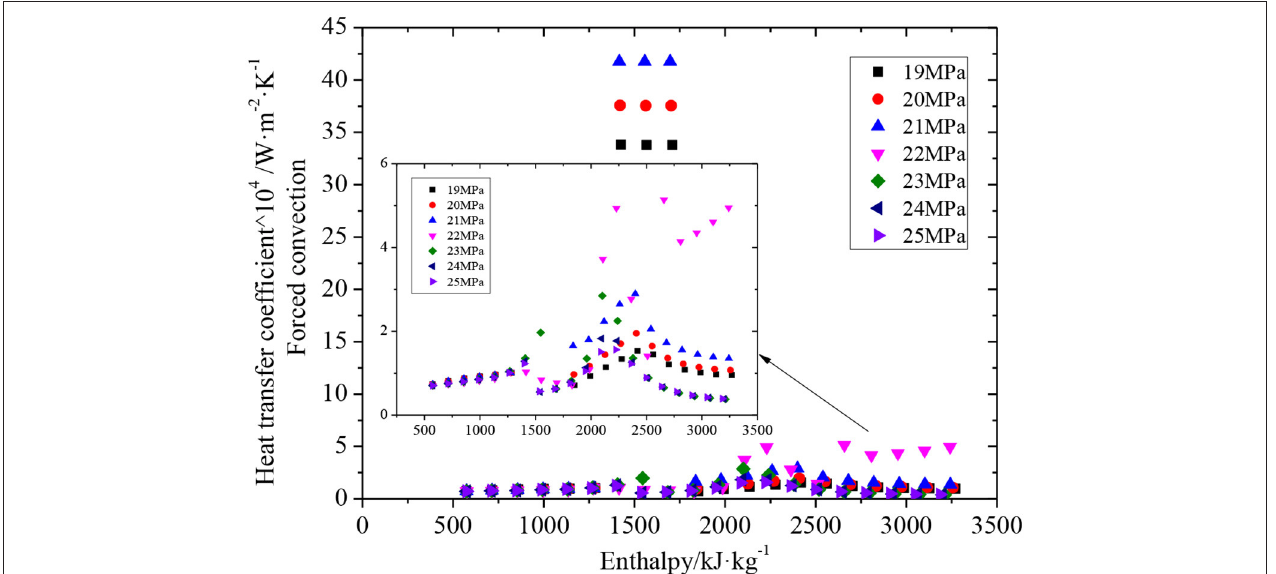
FIGURE 4 | Relationship between the heat transfer coefficient, enthalpy and pressure in a high-pressure region.